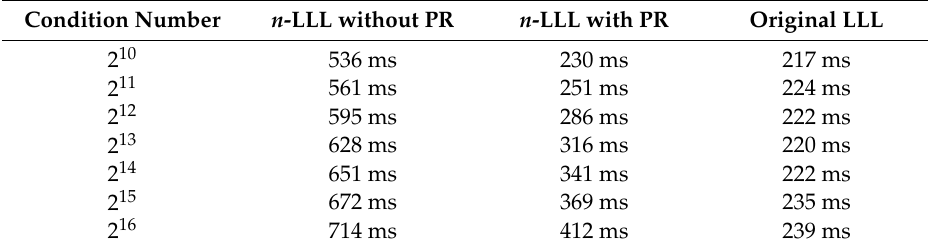
Table 1. The executing time of n -LLL reduction and LLL